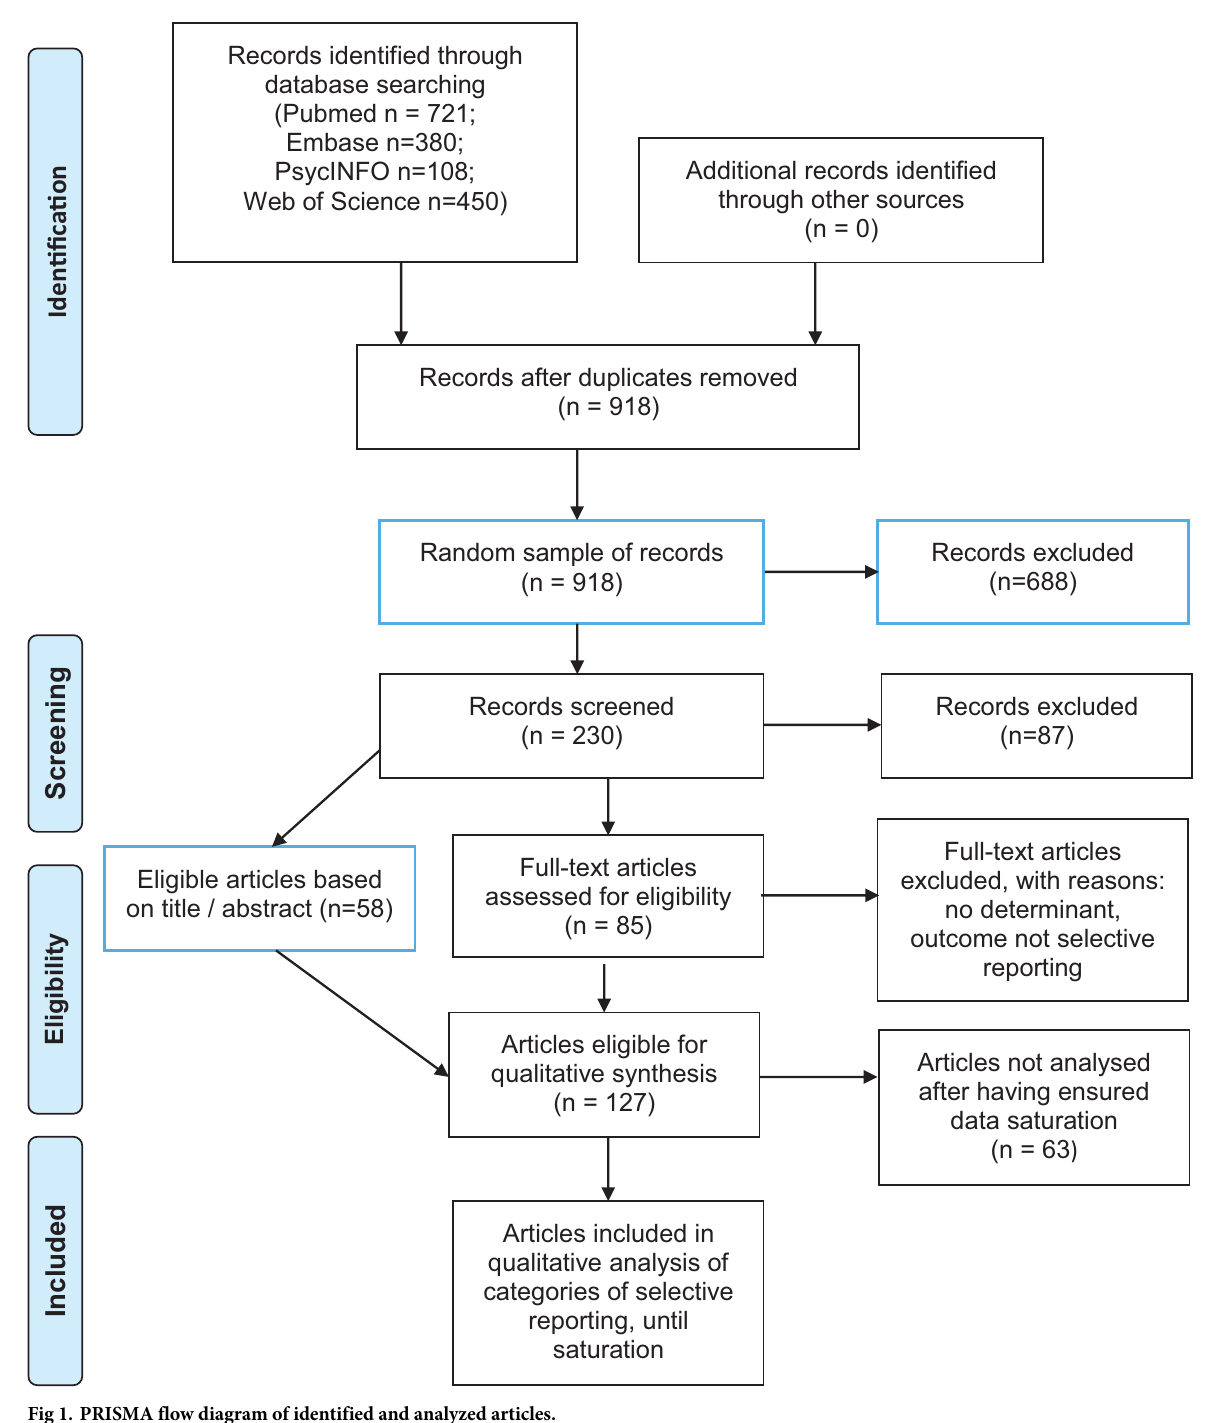
Fig 1. PRISMA flow diagram of identified and analyzed